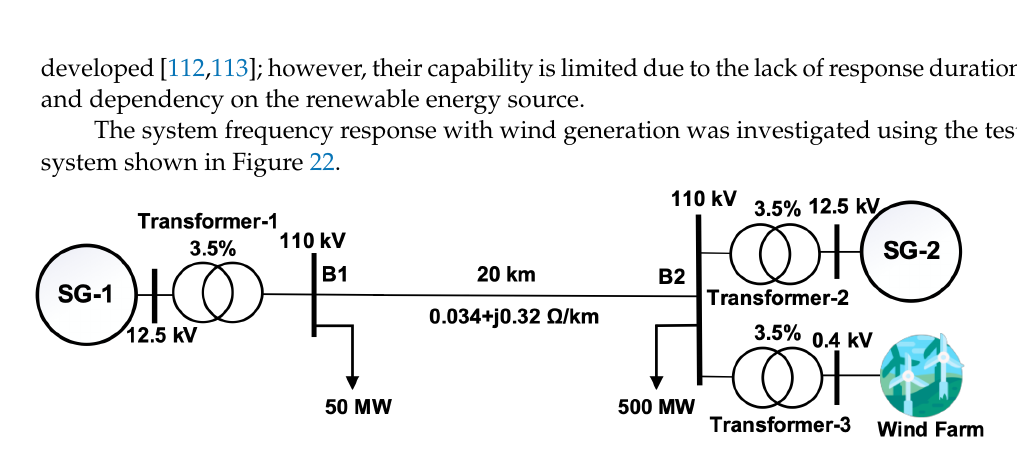
Figure 22. Single-machine test system for dynamic performance analysis with different short-circuit ratios.